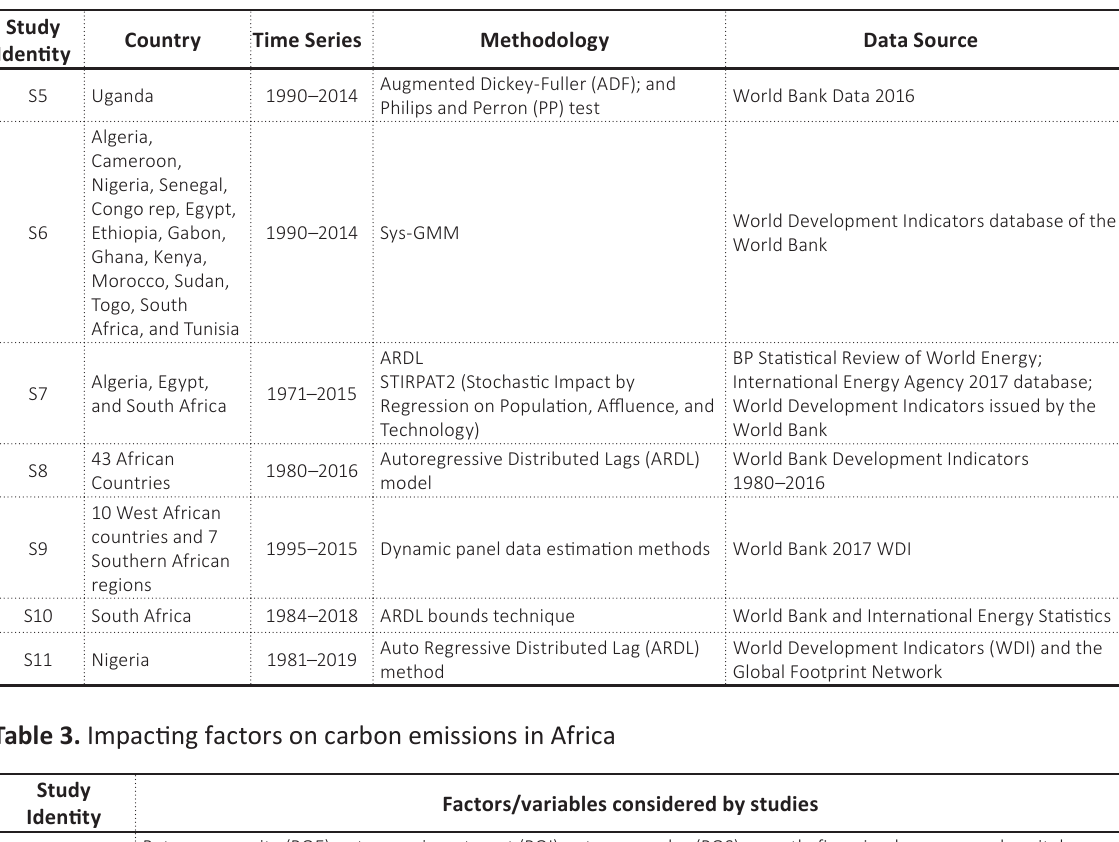
Table 2 (cont.). Selected papers by country, time series, methodology, and data source